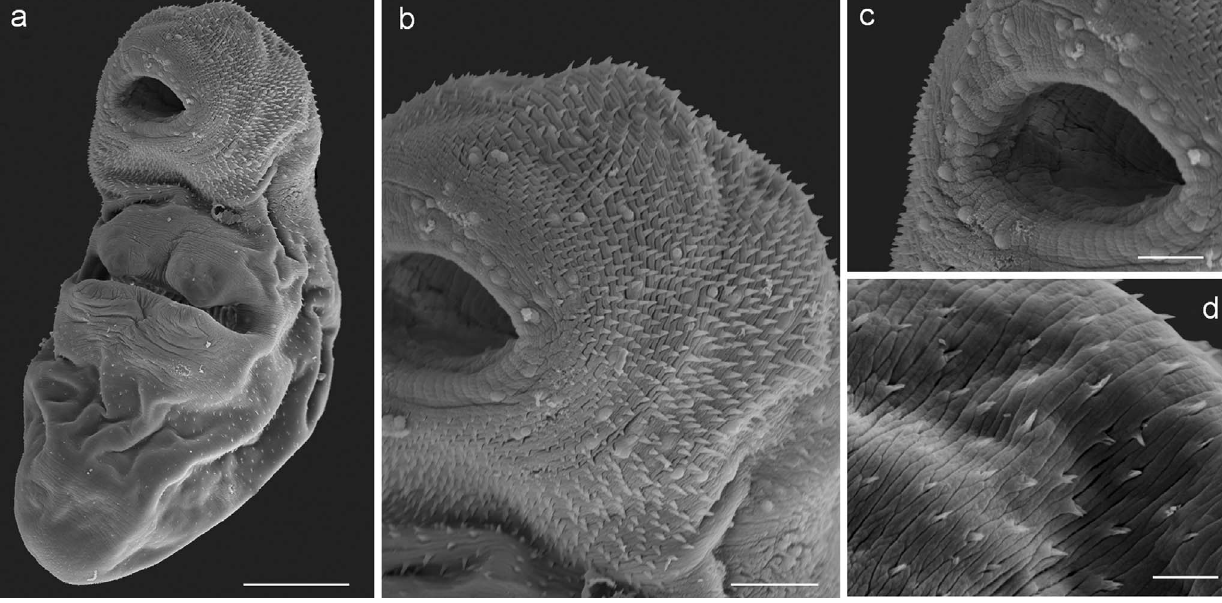
Figure 4. Scanning electron microscope (SEM) photographs of the adult stage of Diphterostomum fl avum n. sp . (Zoogonidae) from the Patagonian coast, Argentina. (a) General ventral view. (b) Anterior part of body showing spines and papillae on ventral side. (c) Oral sucker showing papillae. (d) Detail of spines on ventral posterior part of body. Scales: 100 l m (a), 50 l m (b), 25 l m (c), 10 l m